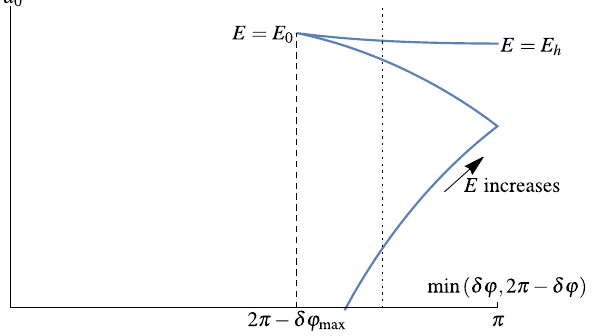
Fig. 13 The coefficient a 0 versus min (δϕ, 2 π − δϕ) for ω = 0 . 25. For this value of ω , π < δϕ max < 2 π . Points on a vertical line are surfaces with the same entangling curve